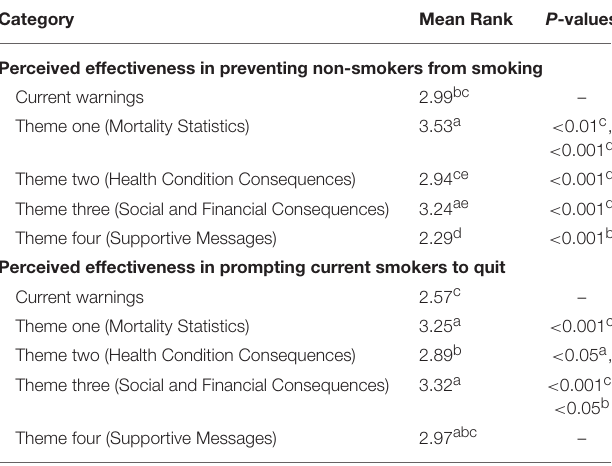
TABLE 2 | Mean ranks of interventions compared to current packaging warnings. Category Mean